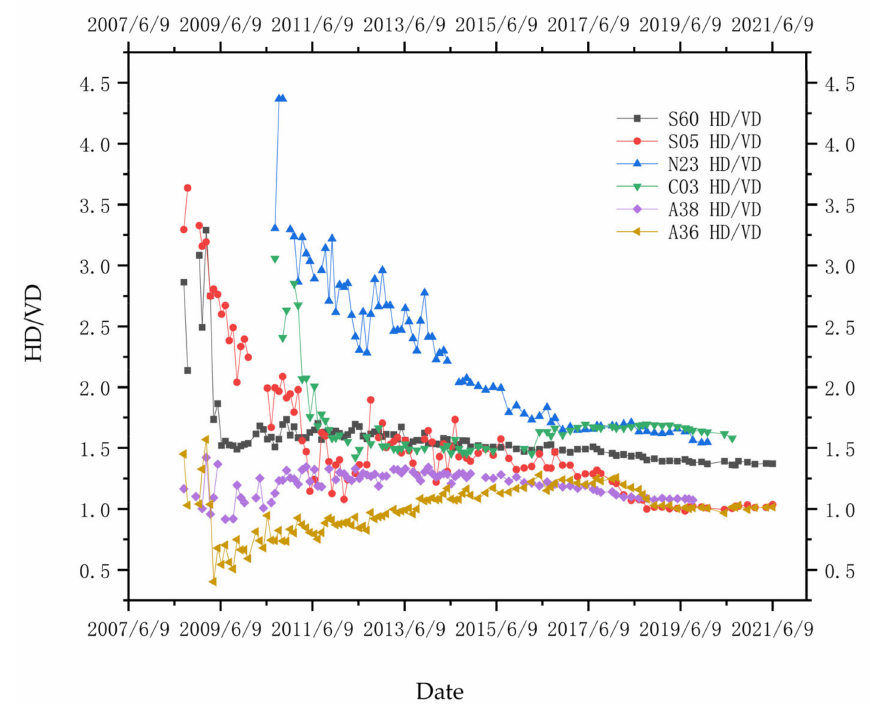
Figure 14. Plots of the HD/VD ratio as a function of time at various GPS monitoring points (HD stands for horizontal displacement; VD stands for vertical